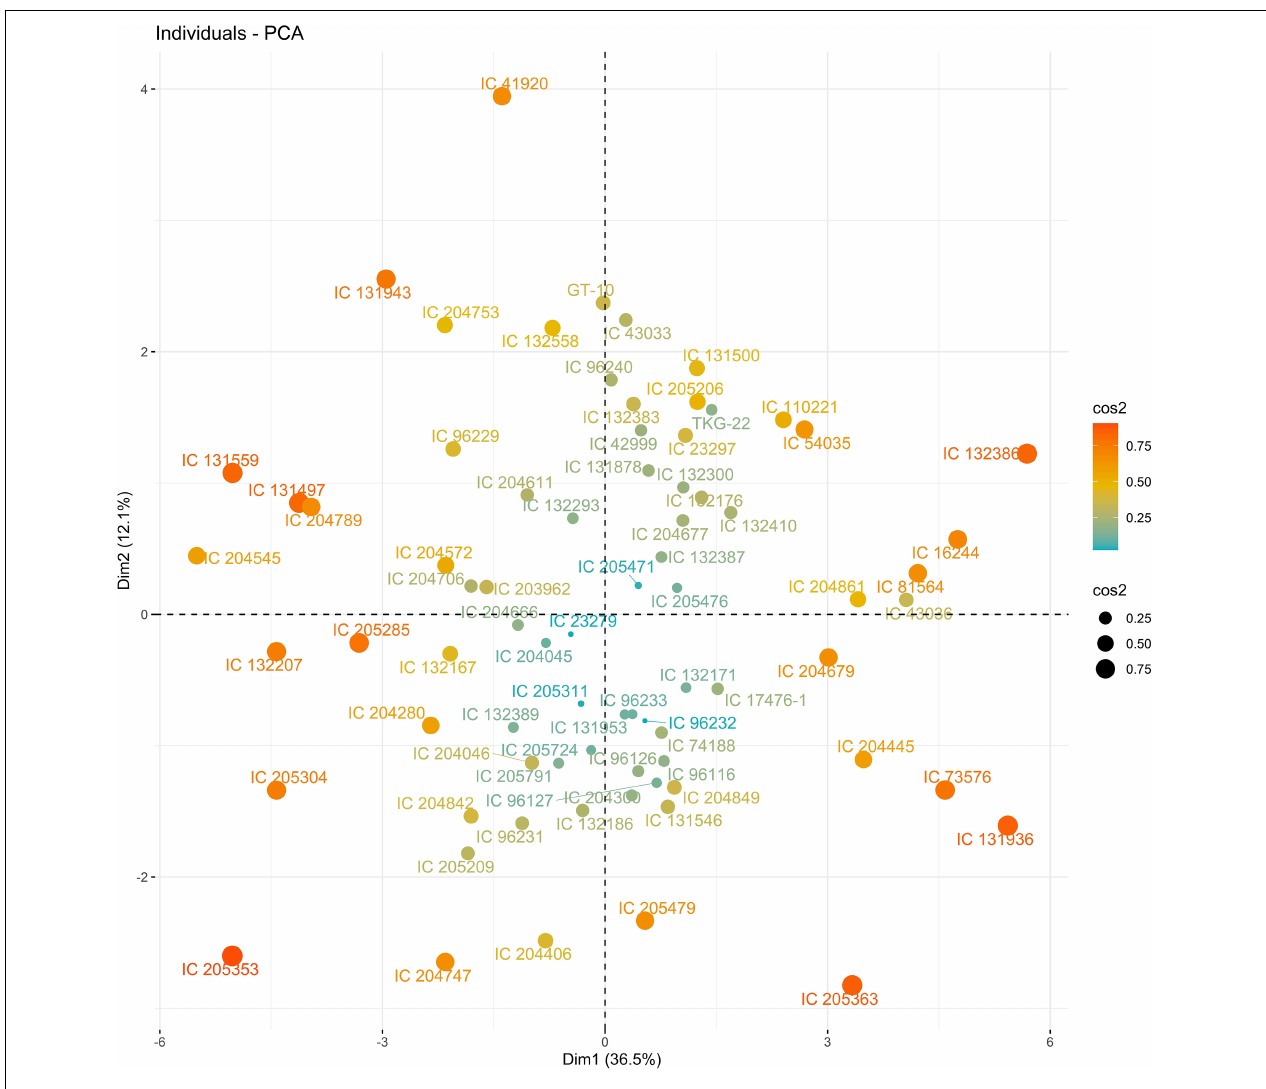
FIGURE 5 | Principal scatter plot of the first two principal component analysis (PCA) of 76 sesame genotypes during year 2018 under well-watered (WW)